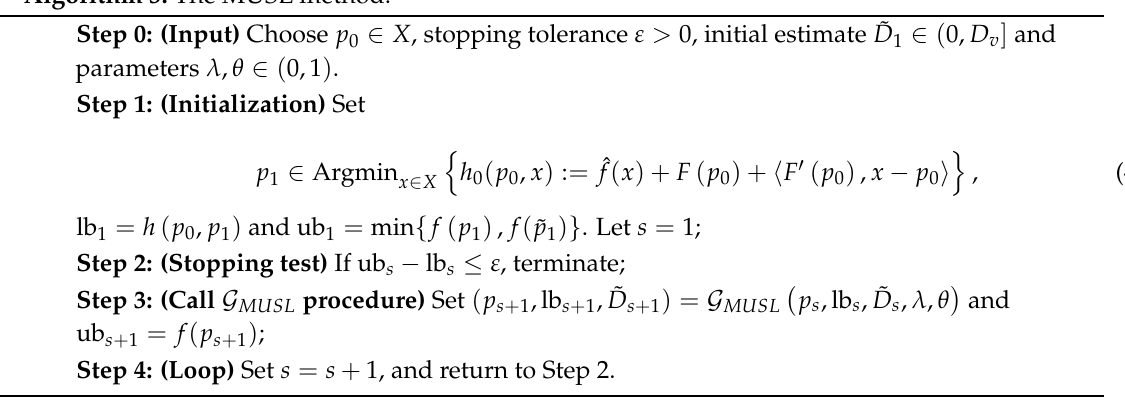
Algorithm 3: The MUSL